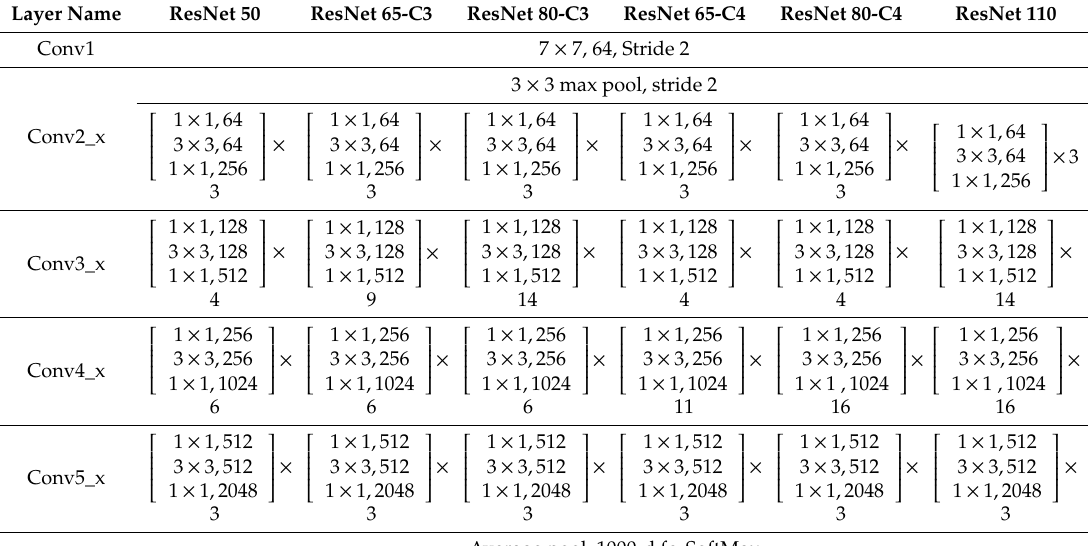
Figure 10. General workflow of object recognition of an urban water body based on deep learning. Table 2. Layers and details of ResNet structure of di ff erent